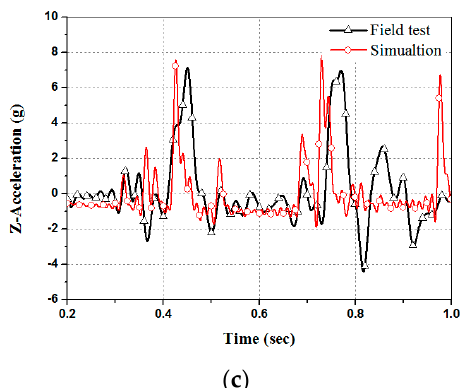
Figure 14. The comparison of accelerations between the field test and the simulation (40 Hz low pass filter). ( a ) X-acceleration; ( b ) Y-acceleration; ( c ) Z-acceleration.